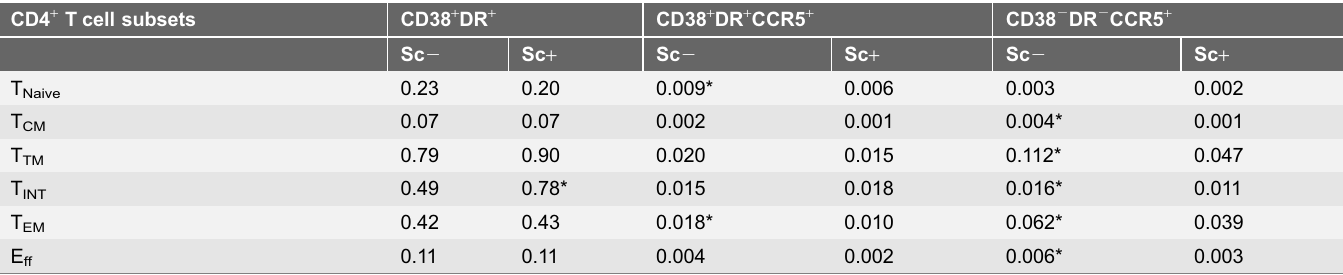
Table 1. Frequency (median) of CD4 + T cell subsets expressing different combinations of CD38, HLA-DR and CCR5 molecules in PBMC collected before vaccination